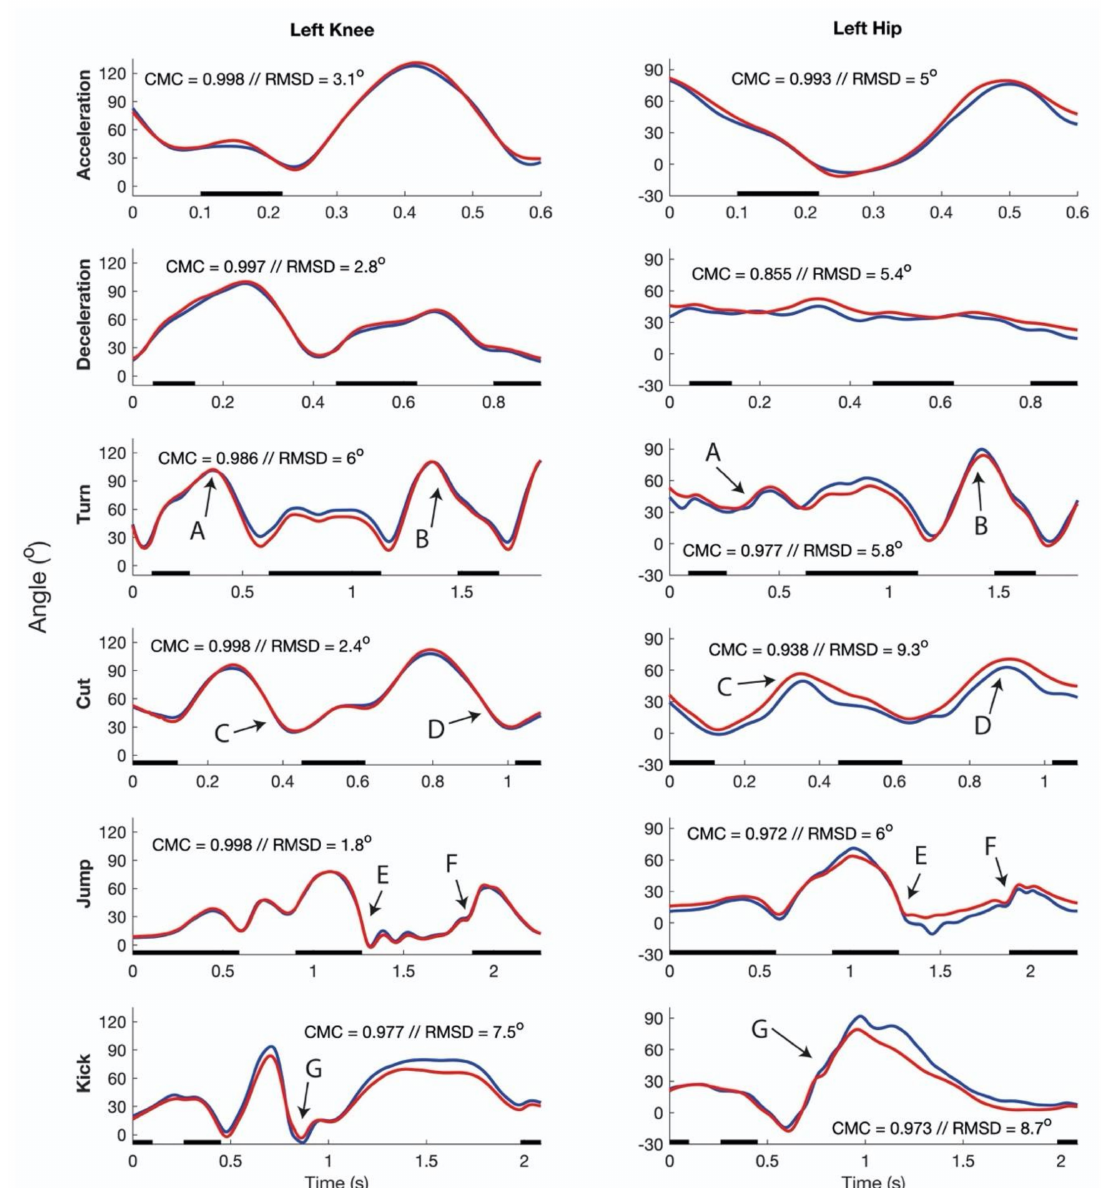
Figure 4. Typical results joint flexion / extension angles. Example of joint flexion / extension angles of the inertial-based motion analysis system (blue line) and the optoelectronic motion analysis system (red line) of all movements performed at maximum intensity by one participant. The black line indicates when the foot is in contact with the ground. For each joint and movement, the coe ffi cient of multiple correlation (CMC) and root mean square di ff erence (RMSD) is indicated in the respective graph. The arrows indicate events and have the following meanings: A = turn initiation, B = turn completion, C = cut initiation, D = cut completion, E = push-o ff , F = landing, G = moment of ball